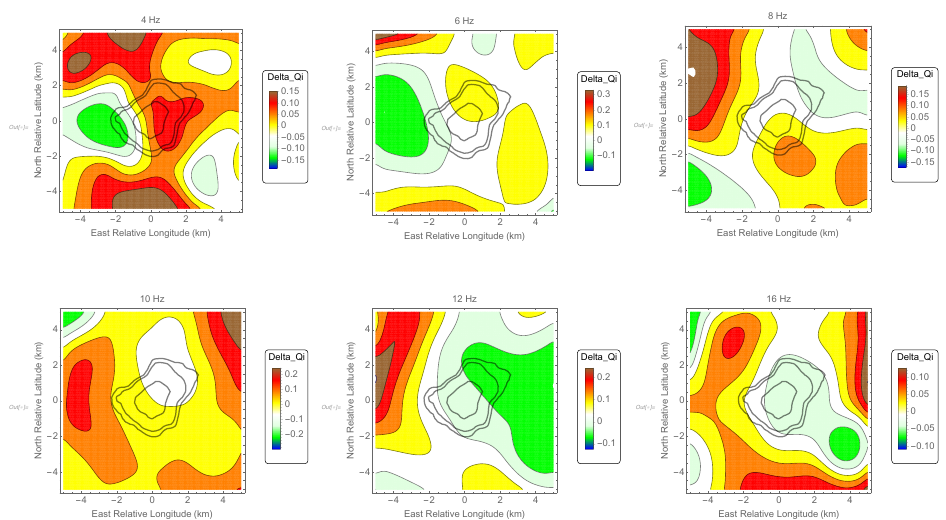
Figure 11. 2D space distribution of intrinsic attenuation parameters. Instead of the absolute values of inverse Q − 1 , we plot their percent fluctuations respect to the space average of Q − 1 i the reader is focused to the attenuation space changes, more useful for the geological interpretation. The six panels represent the intrinsic attenuation fluctuations in six frequency bands, indicated at the top of each